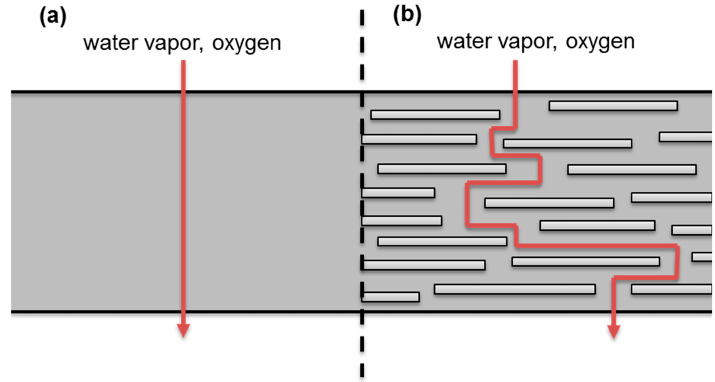
Figure 1. Illustration of the “tortuous pathway” created by the incorporation of exfoliated nanoplatelets into a polymer matrix film. Adapted from [23]. Other effects, like the selective adsorption of gas molecules on the particles of a high specific surface area, are also involved. Nanoplatelets composed of clays or other silicate materials, such as montmorillonite [(Na,Ca) 0.33 (Al,Mg) 2 (Si 4 O 10 )(OH) 2 ∙ nH 2 O)], a layered phyllosilicate composed of anisotropic layers separated by water molecules, are the most studied for this application. The platelets have a thickness in the nanometre range, lateral dimensions from tens of nanometres up to several microns, surface areas above 750 m 2 /g and an aspect ratio in the range of 100–500 [3]. When increasing the affinity between the matrix and fillers, nanoclay ‐ based composites can show three different types of morphology: immiscible (e.g., microscale dispersion, tactoid), intercalated or exfoliated (miscible) composites [24,25] (Figure 2). The former of course does not allow the material to reach the properties promised by nanocomposites, while the latter two allow incremental improvements. Figure 2. Scheme of different types of composite arising from the interaction of clays and polymers: ( a ) phase separated microcomposite; ( b ) intercalated nanocomposite; and ( c ) exfoliated nanocomposites. Adapted from [26].